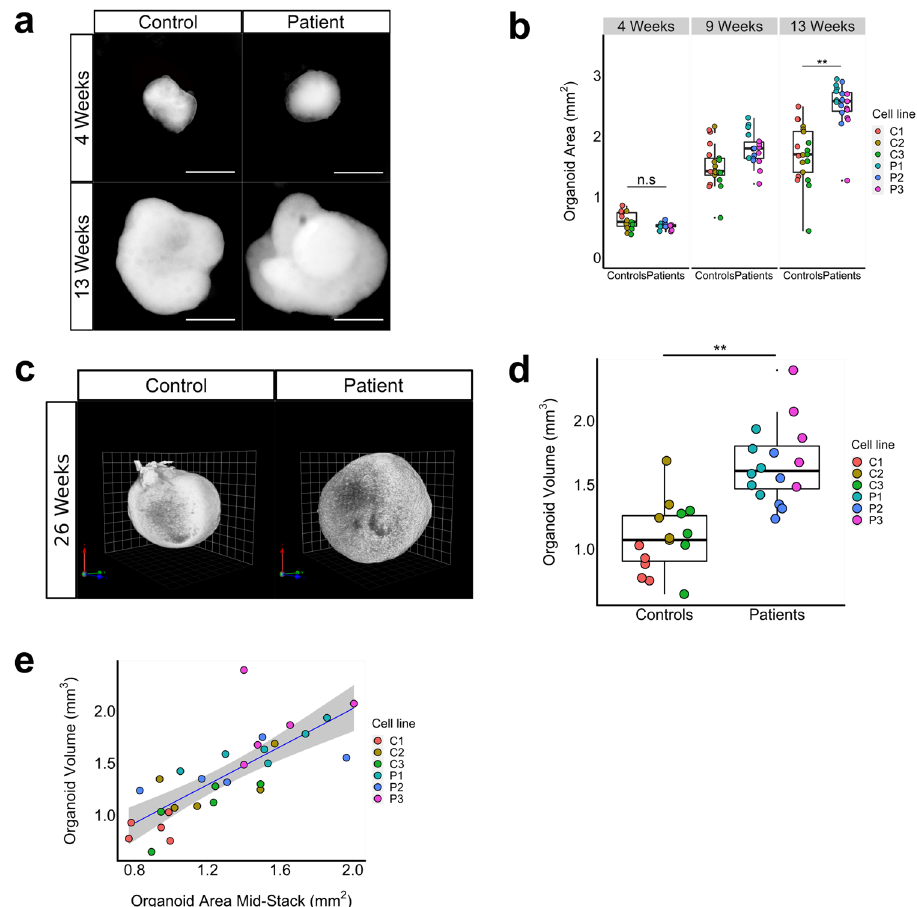
Fig. 2 Patient-derived forebrain organoids display an increase in volume. a , b Representative image of bright fi eld images of patient- and control-derived organoids over time ( a ) and quanti fi cations based on 2D bright fi eld image measurements ( b ), showing an increase in surface area at 9 weeks and a 1.5- fold increase in area of patient-derived versus control-derived organoids at week 13 (Likelihood Ratio Test (LRT), p = 0.002, χ 2(1) = 9.42, n = 3 cell-lines/ genotype, C1: n = 7 organoids (orgs), C2: n = 7 orgs, C3: n = 7 orgs, P1: n = 6 orgs, P2: n = 6 orgs; P3: n = 6 orgs), while no difference in size was observed at week 4. Scale bar represents 500 μ m. c , d Representative image of light-sheet microscopy images of control- and patient-derived cortical organoids at 26 weeks in vitro ( c ) and volumetric quanti fi cation of light-sheet images showing a 1.5-fold volumetric increase for patient-derived cortical organoids compared to controls ( d ); (LRT, p = 0.005, χ 2(1) = 7.85, n = 3 cell-lines/genotype, C1,C2,C3,P2,P3: n = 5 orgs, P1: n = 6 orgs). e Scatterplot showing the relationship between the area of a middle z-stack of a light-sheet image of a forebrain organoid and the volume at 26 weeks as measured by the 3D rendering of the light-sheet image. We constructed a linear model of volume as a function of the area of the middle z-stack (blue line) ( F (1,29) = 44.59, R 2 = 0.606, p = 2.529e-07). The shaded gray area represents the constructed 95% con fi dence interval around the mean. This result indicates that 2D bright fi eld microscope images can be used to reliably estimate organoid volume. Boxplots display median, fi rst and third quartiles, and whiskers showing the largest and smallest values no further than 1.5 times the inter quartile range from fi rst and third quartile, respectively. * p < 0.05; ** p < 0.01; *** p <